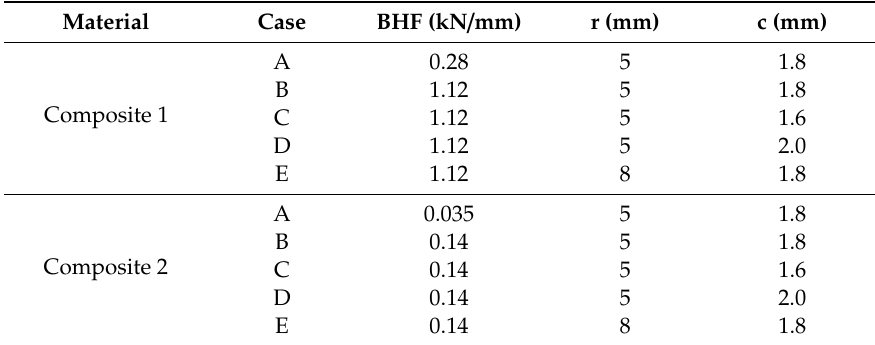
Table 3. Combinations of U-channel forming process parameters used for the simulations of Composite 1 and Composite 2.